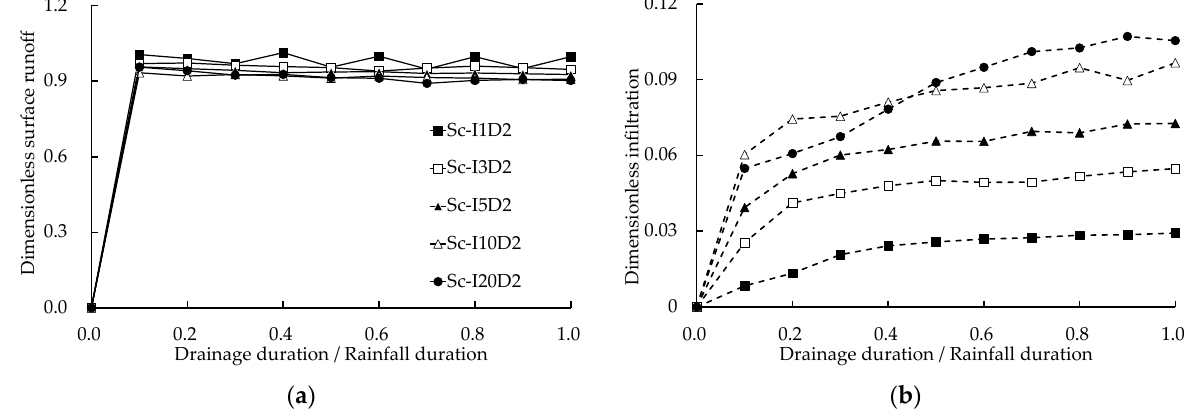
Figure 11. Results of scaled model simulation for 200 s: ( a ) surface runoff; ( b ) infiltration.